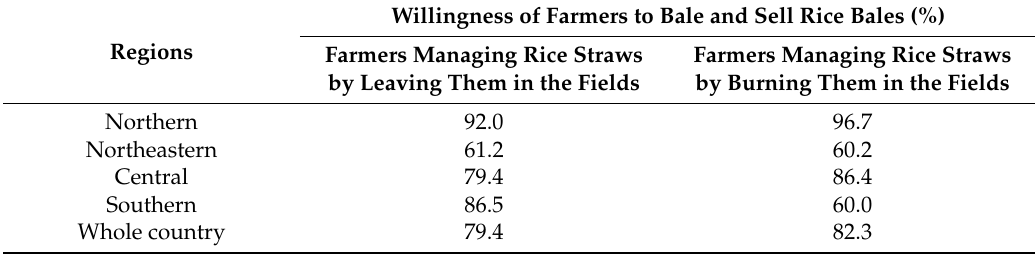
Table 3. Characteristics of rice bale from the baling